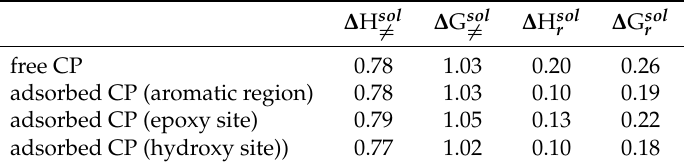
∆ G sol Table 6. Aqueous solution activation enthalpies ( ∆ H sol (cid:54) = ) and free energies ( (cid:54) = ) variations for the first hydrolysis reaction of CP physically adsorbed on GO and rGO. Corresponding reaction enthalpies ( ∆ H sol r ) and free energies ( ∆ G sol r ) are also reported. The reported values refer to the adsorption on C 32 H 14 -based prototypes (see first column of Figure 1). All values are in eV (1 kcal/mol = 0.043